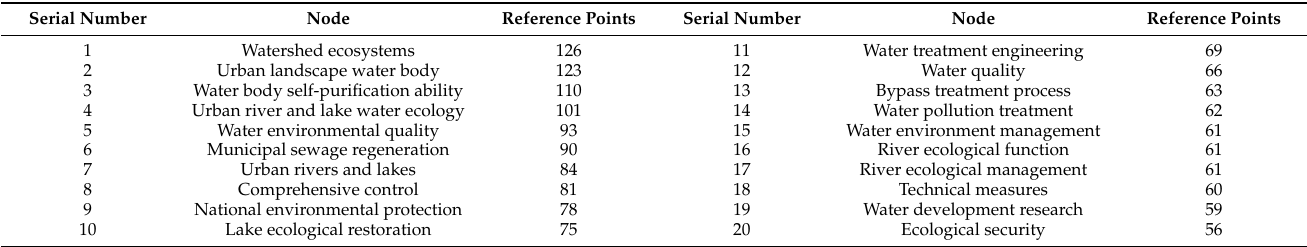
Table 8. Summary of topic nodes and reference points of CNKI automatic